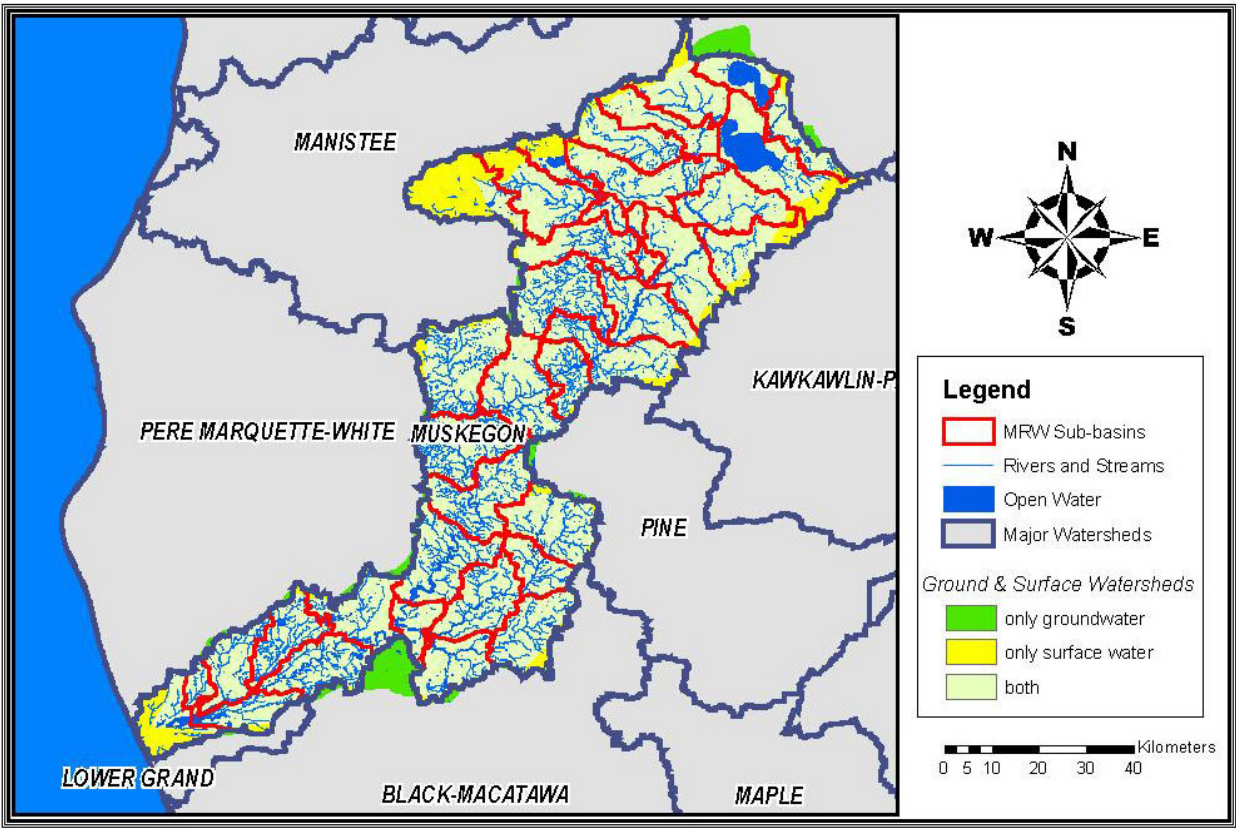
Fig. 3 . Distribution of the surface and groundwater watersheds and surface watershed sub-basins and major rivers and streams in the Muskegon River